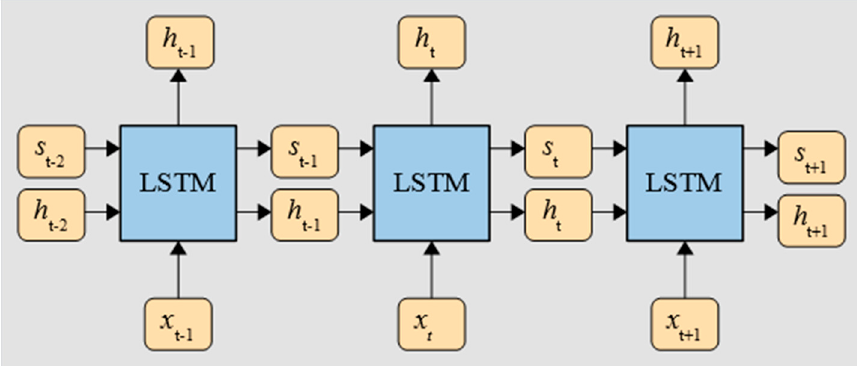
Figure 2. The training process of LSTM.